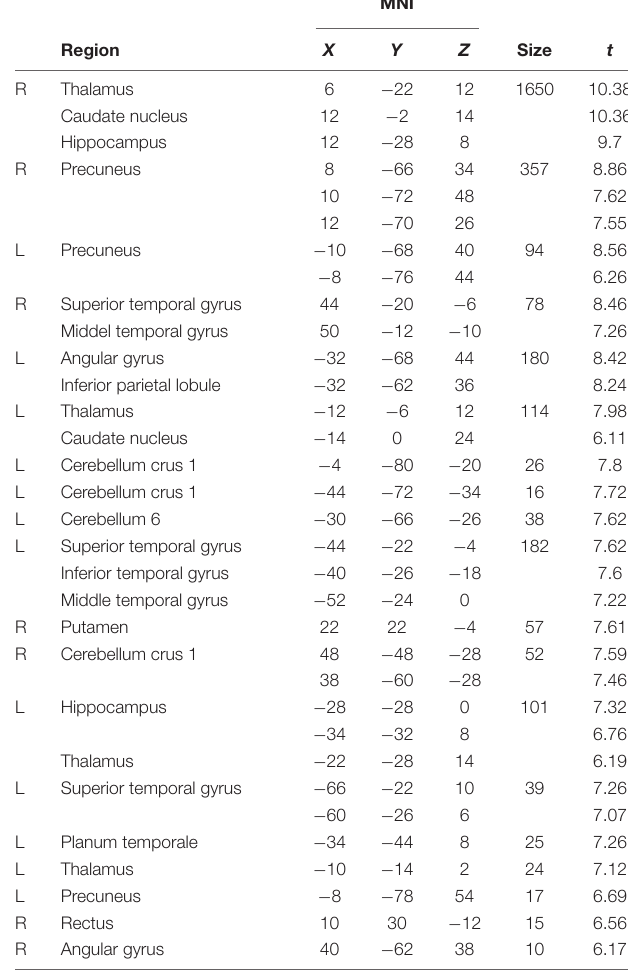
TABLE 2 | Effect of Time (LEARNING >